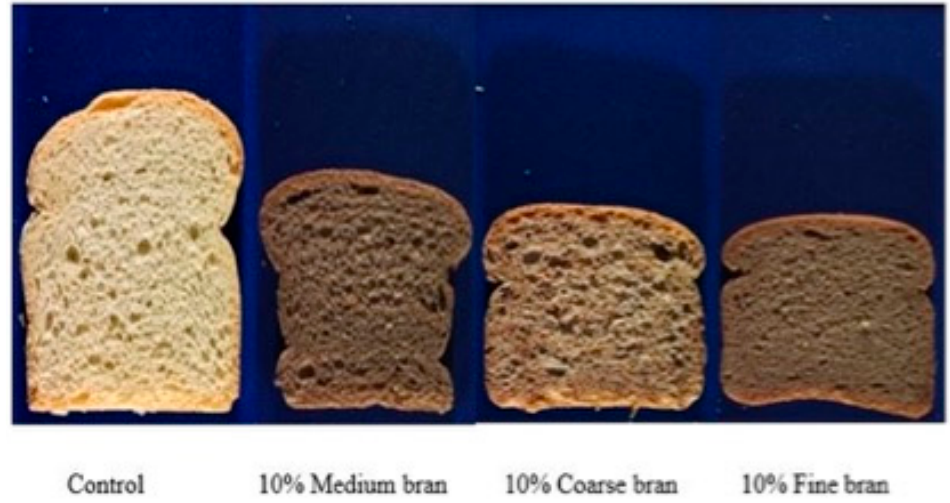
Figure 11. Effects of bran particle size on loaf volumes and crumb structures, for doughs containing 10% Coarse, Medium and Fine bran, sheeted at a roll gap of 12 mm for 8 sheeting passes.